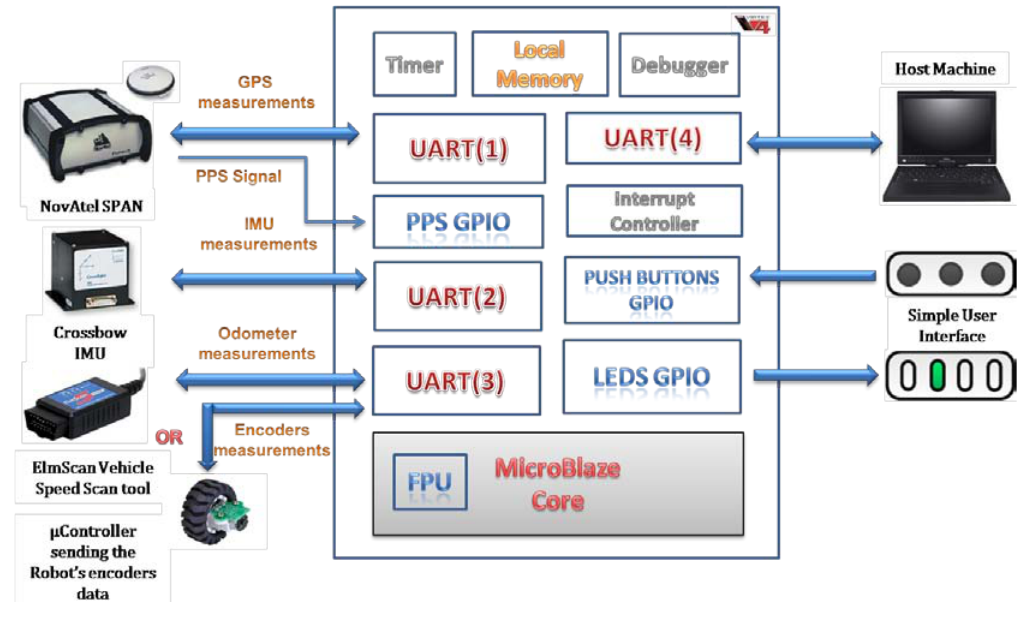
Figure 7. Customized MicroBlaze-based Navigation Embedded